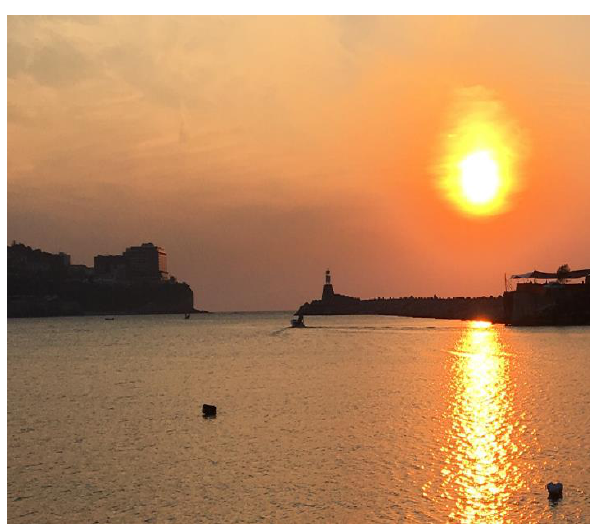
Figure 2. Normal visibility range in Zonguldak (PM 10 = 40 µg/m 3 ).